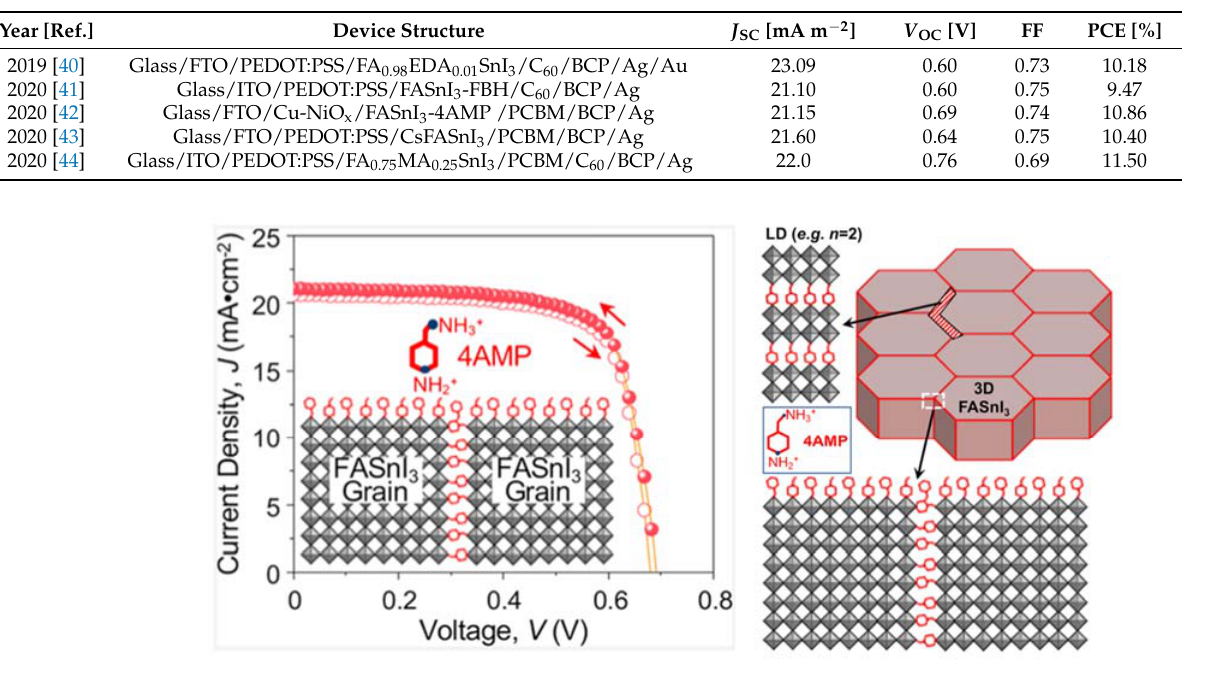
Figure 5. Schematic illustration of the optimum 4AMP functionalisation of grain surfaces and grain boundaries in FASnI 3 perovskite polycrystalline thin film, together with the J–V curves of the devices showing negligible hysteresis. Reprinted with permission from ref. [42] Copyright 2020, the American Chemical Society.